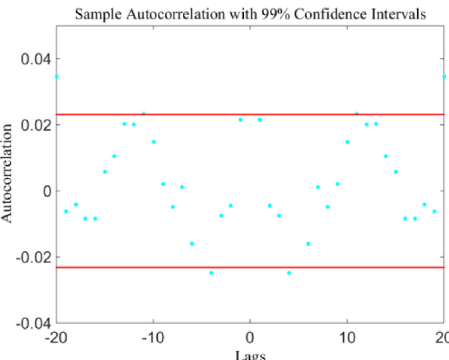
Fig. 5. Autocorrelation of residuals from NARX network optimized by GA-OBS with 99% con fi dence interval.